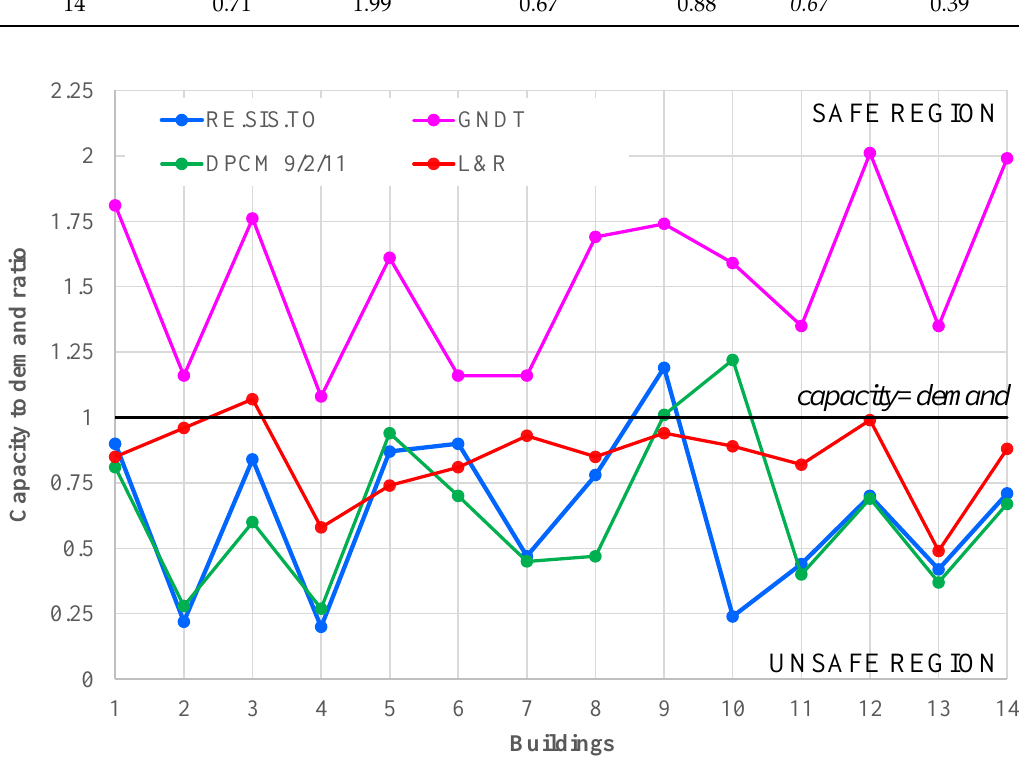
Figure 12. Comparison of quantitative vulnerability judgments from methods of Group B.